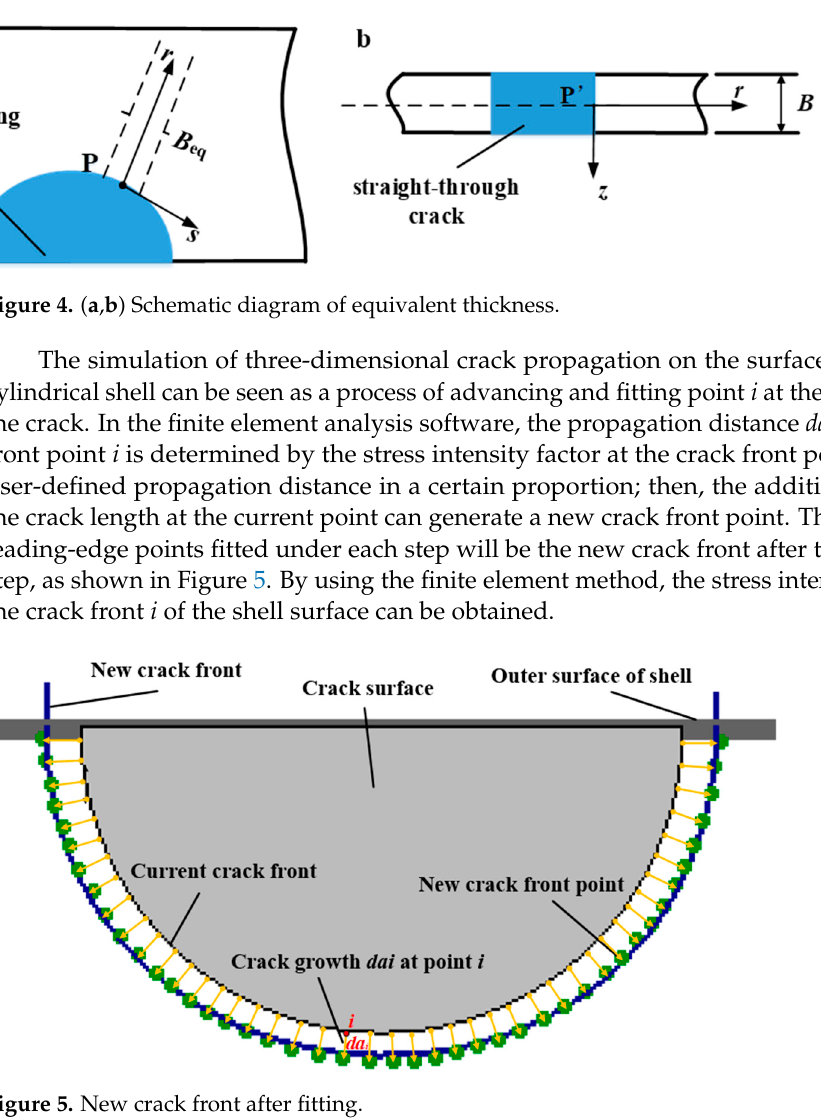
Figure 4. Schematic diagram of equivalent thickness.